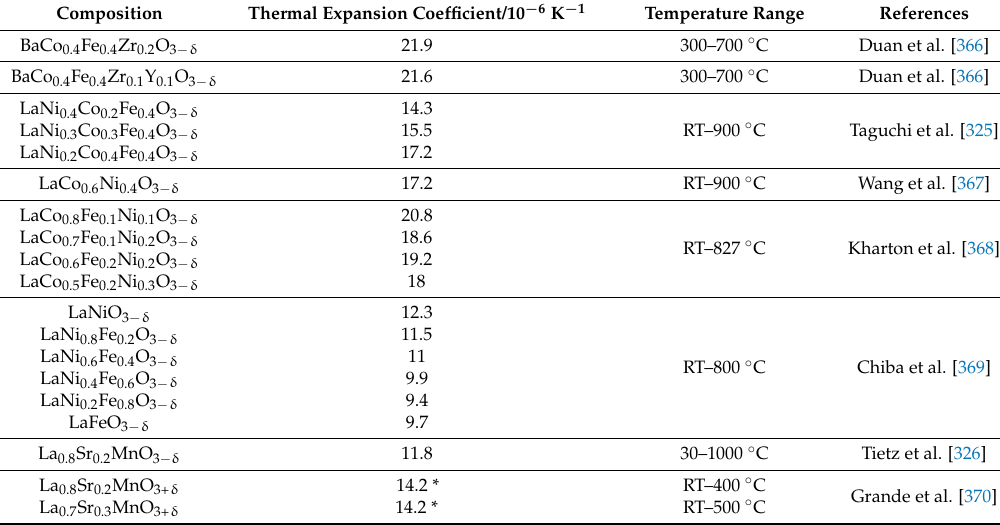
Table 11. Linear thermal expansion coefficients of single perovskite electrode materials, other than LSCF and